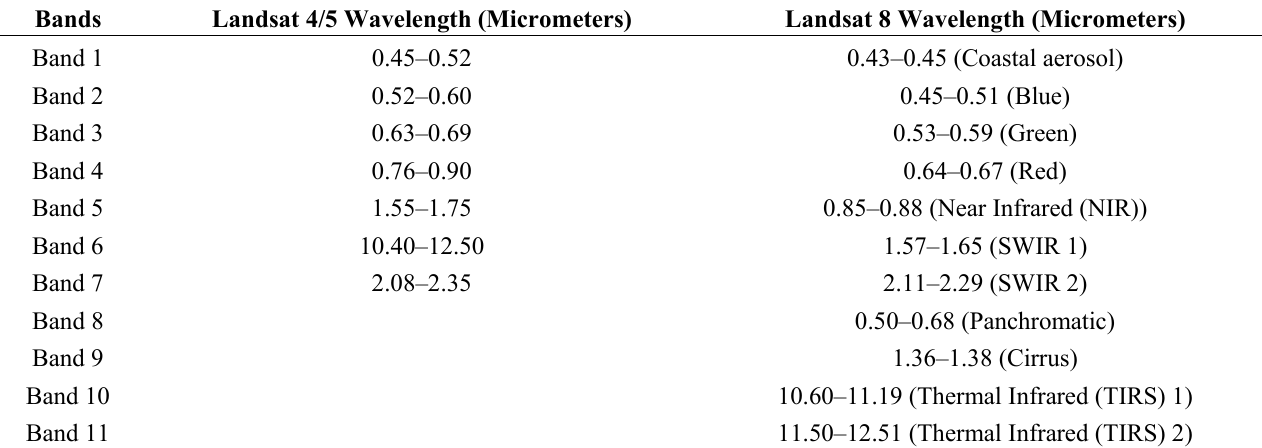
Table 1. Spectral characteristics of the 7 bands from Landsat 4/5 TM image and the 11 bands from Landsat 8 image.